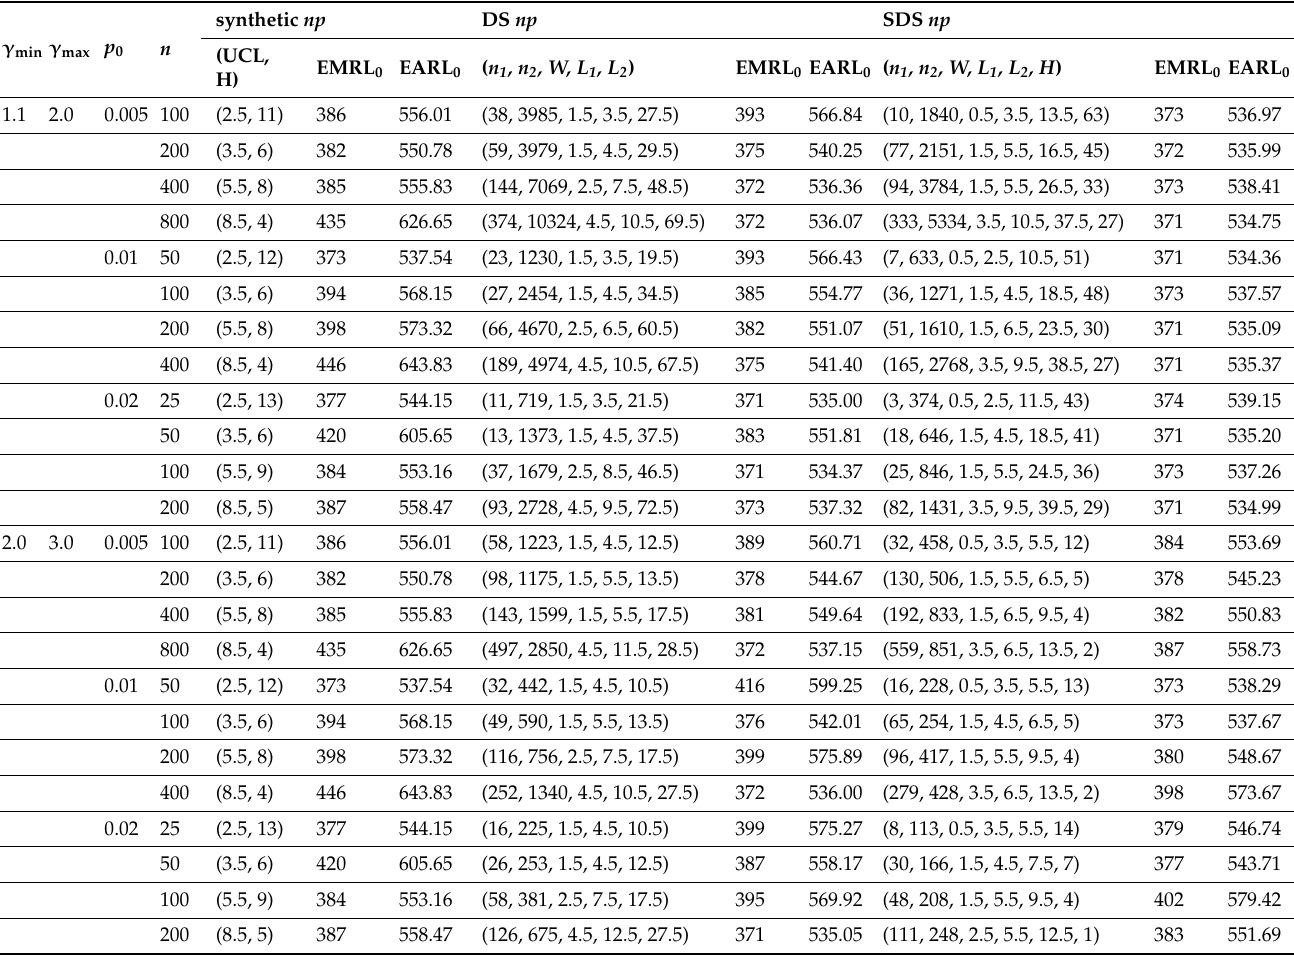
Table 4. Optimal charting parameters for the SDS np , synthetic np and DS np charts, based on EMRL, in SS mode, together with their corresponding MRL 0 and ARL 0 values, when MRL 0min = 370.4.